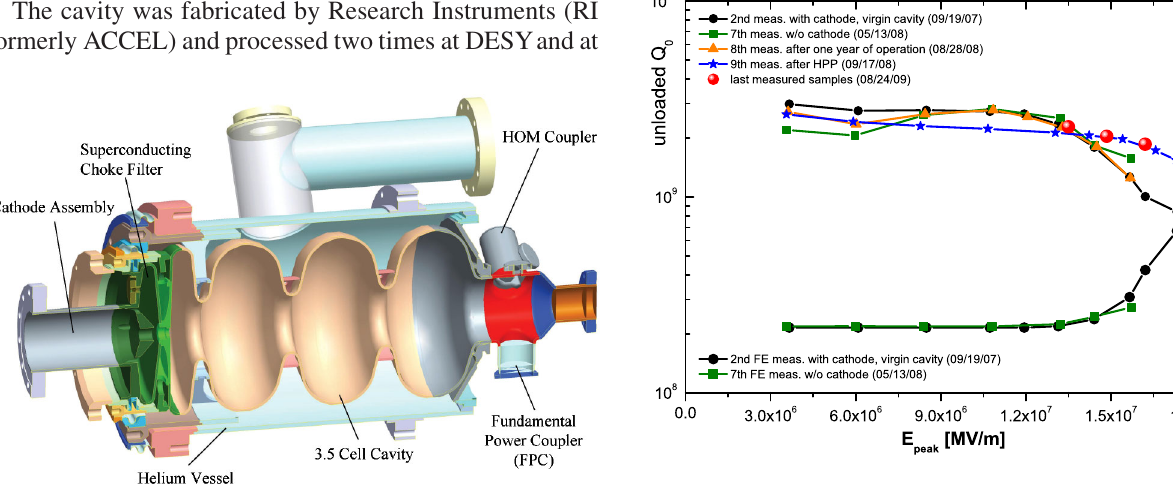
FIG. 3. Intrinsic quality factor Q 0 vs on-axis peak field E peak and the corresponding field emission dose for different